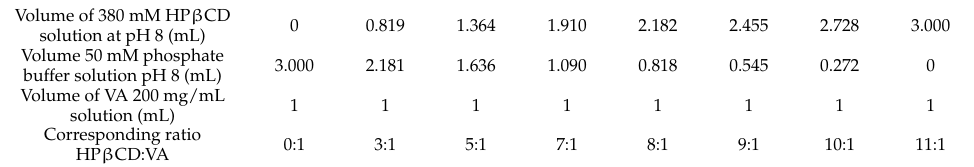
Table 5. Preparation of vancomycin (VA)/2-hydroxypropyl- β -cyclodextrin (HP β CD) solution for the study of the impact of HP β CD on